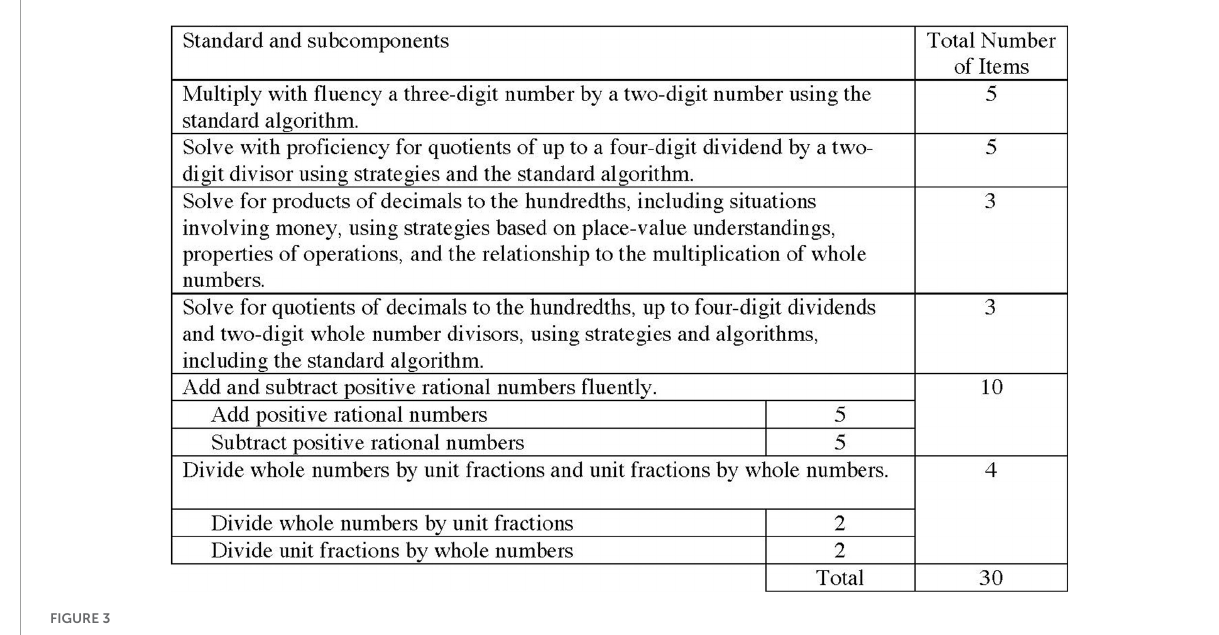
FIGURE3 Blueprint for Grade